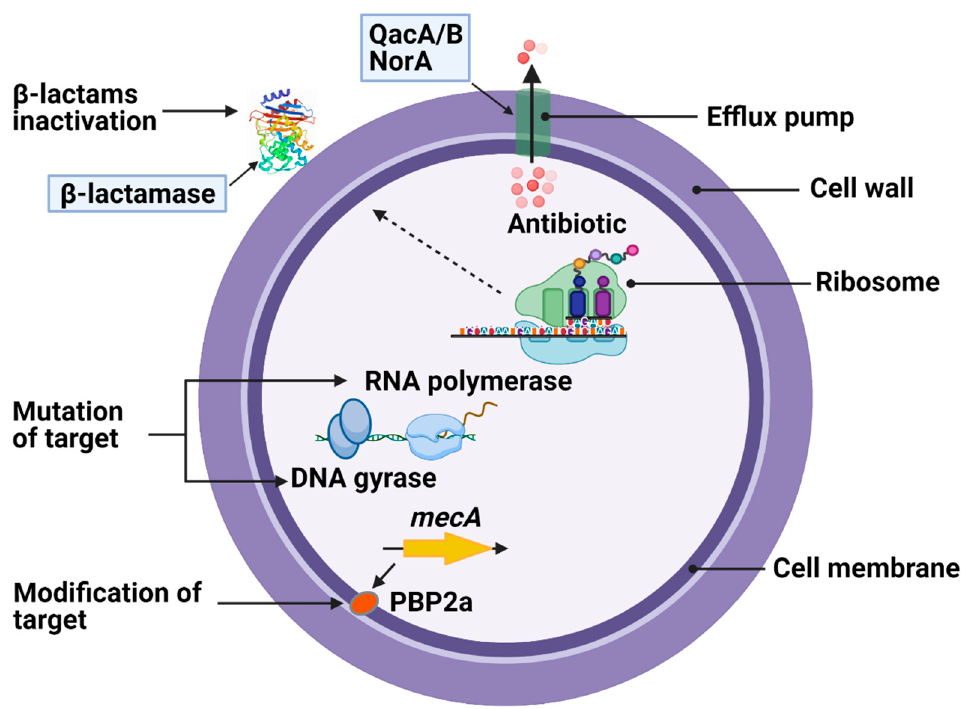
Figure 1. Molecular mechanisms of antibiotic resistance in Staphylococcus aureus . Antimicrobial resistance occurs due to the mutation or modification of antibiotic targets, inactivation of β -lactam antibiotics by β -lactamase, a reduction in membrane permeability, or increased activity of efflux pumps.